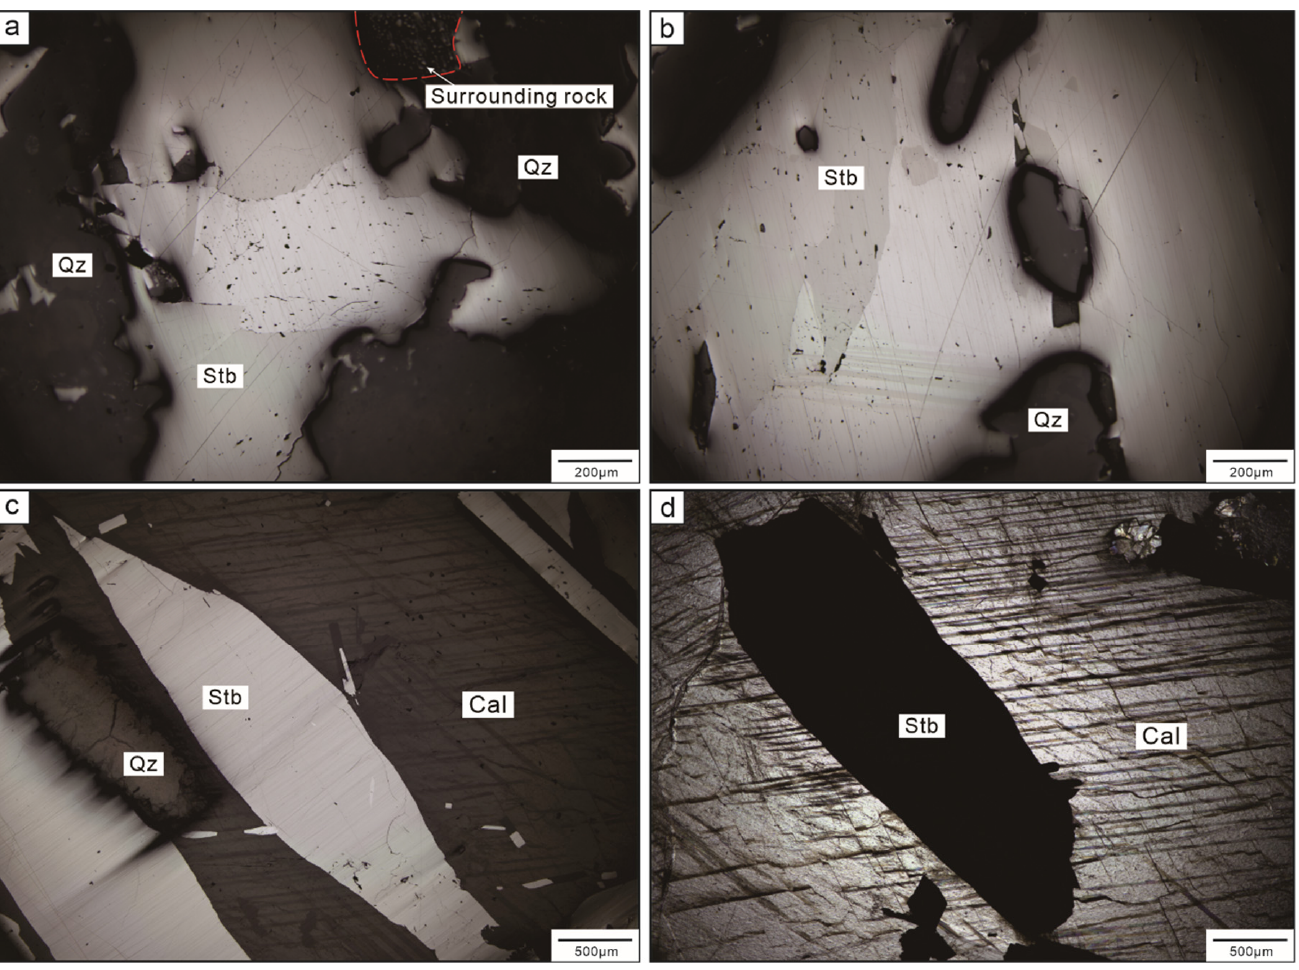
Figure 5. Representative microscopic photographs of the Daocaowan Sb deposit. ( a , b ) Quartz–stibnite ores; ( c ) Quartz–calcite–stibnite ores; ( d ) Calcite–stibnite ore.